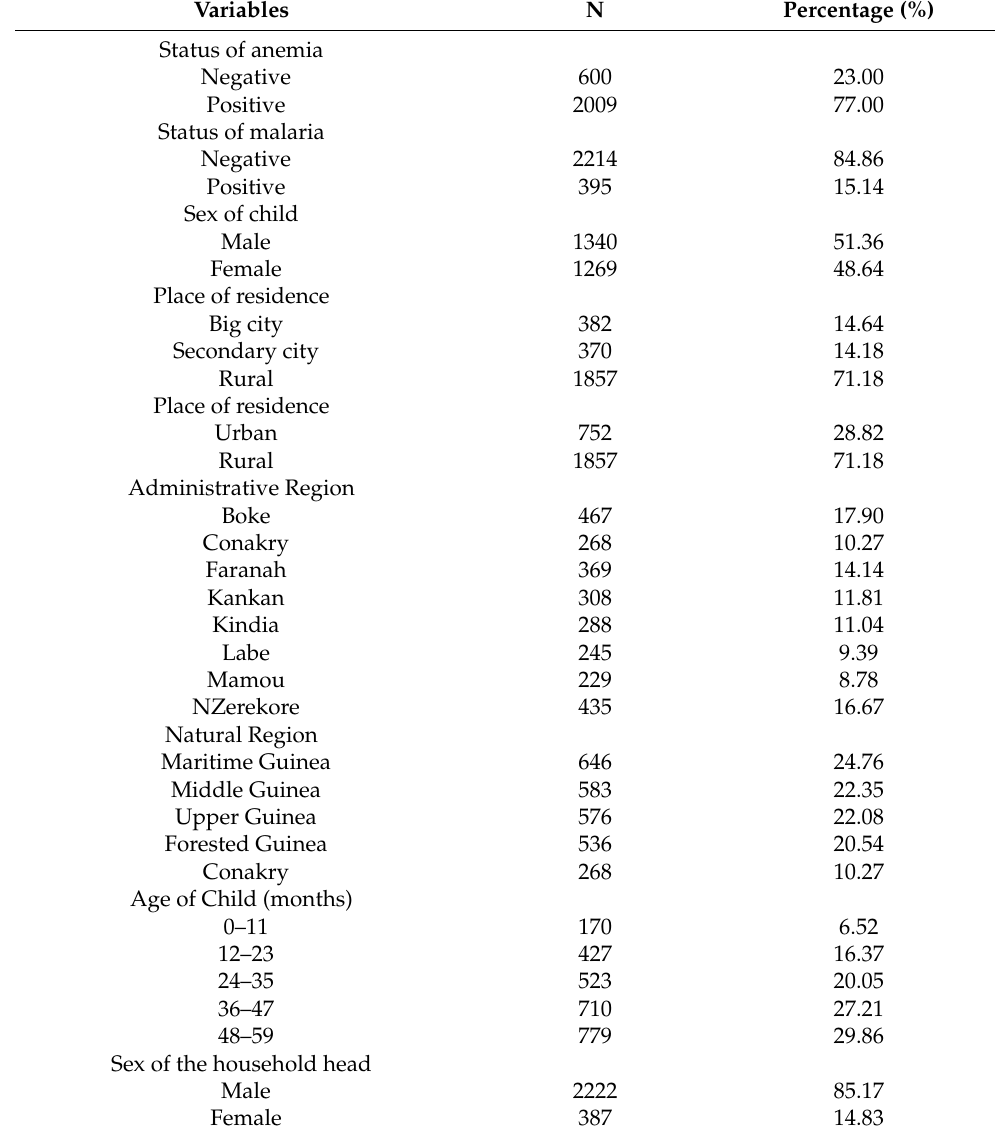
Table 1. Socio-economic and demographic characteristics of the